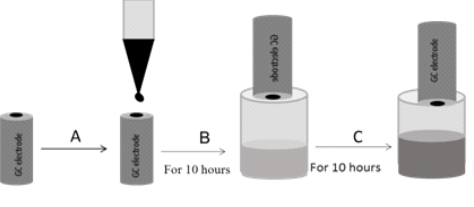
Fig. 1: modification of bioanode ADH/emim Tf